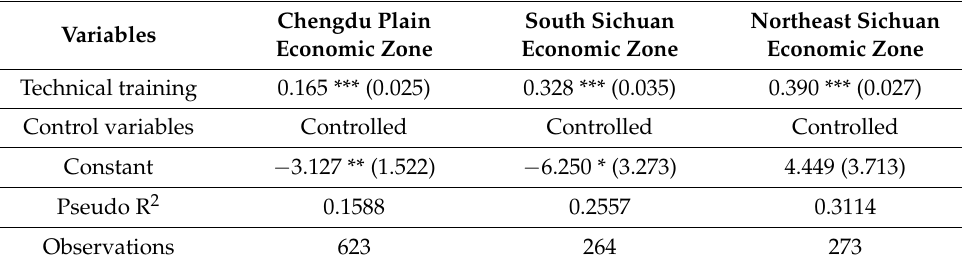
Table 10. Effects disaggregated by groups’ economic